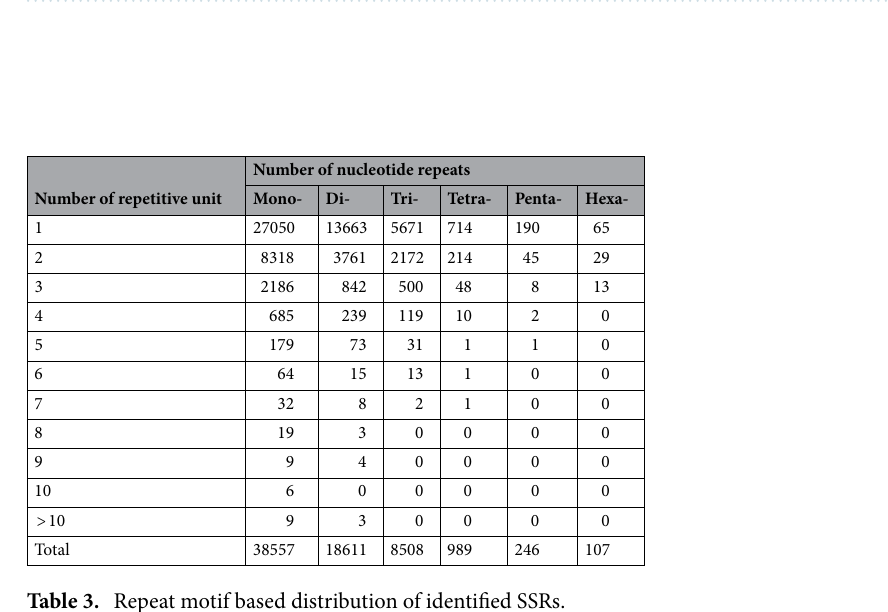
Figure 5. Top hits organism distribution of transcriptome annotation with PMN database.